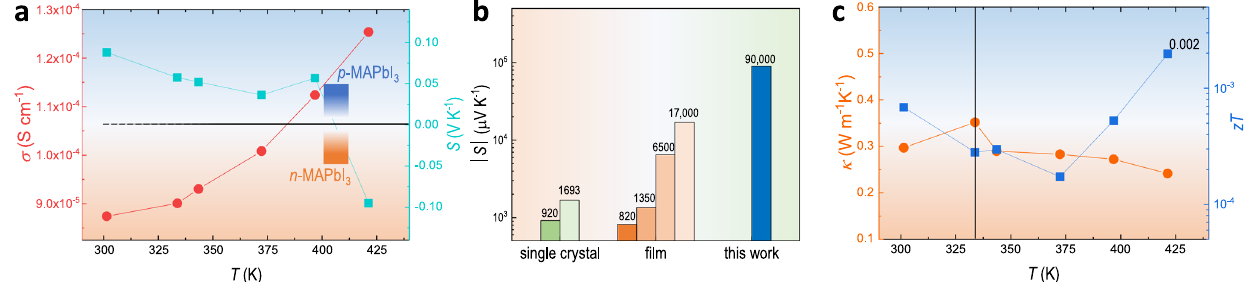
Fig. 3 | Thermoelectric evaluation of FAST-MAPbI 3 . a Temperature-dependent electrical conductivity and Seebeck coef fi cient of FAST-MAPbI 3 . b Comparison of the absolute Seebeck coef fi cient between FAST-MAPbI 3 and state-of-the-art single